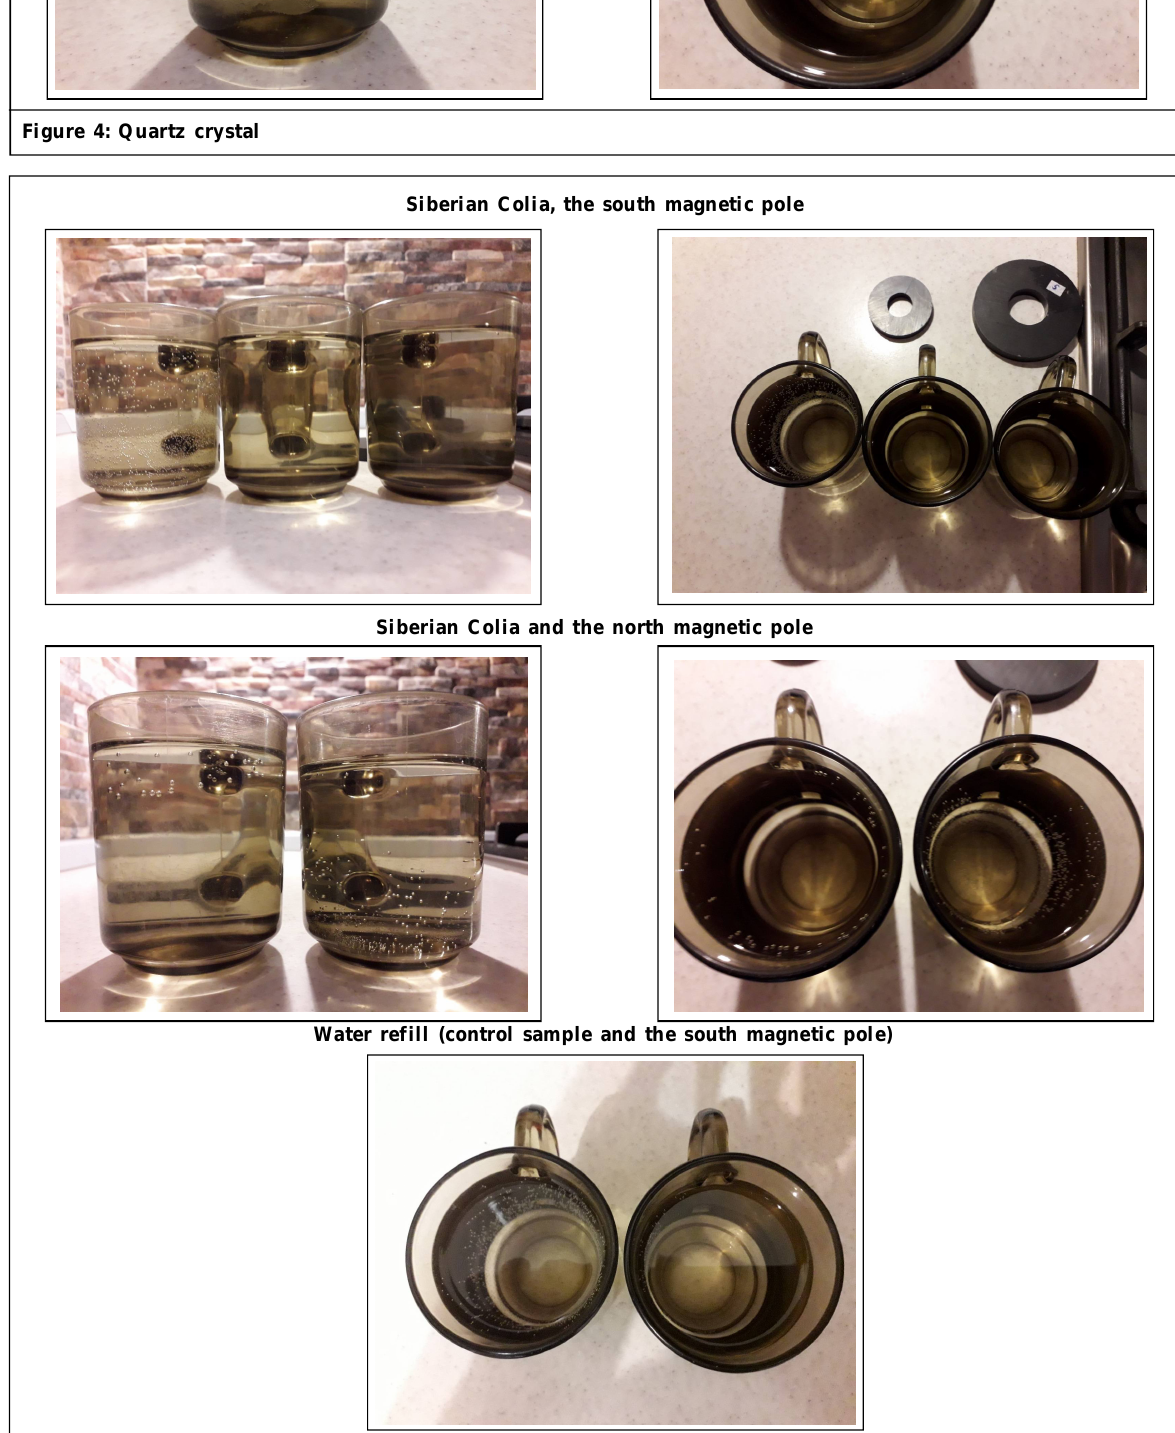
Figure 5: Control, Siberian Colia, the south and north magnetic pole